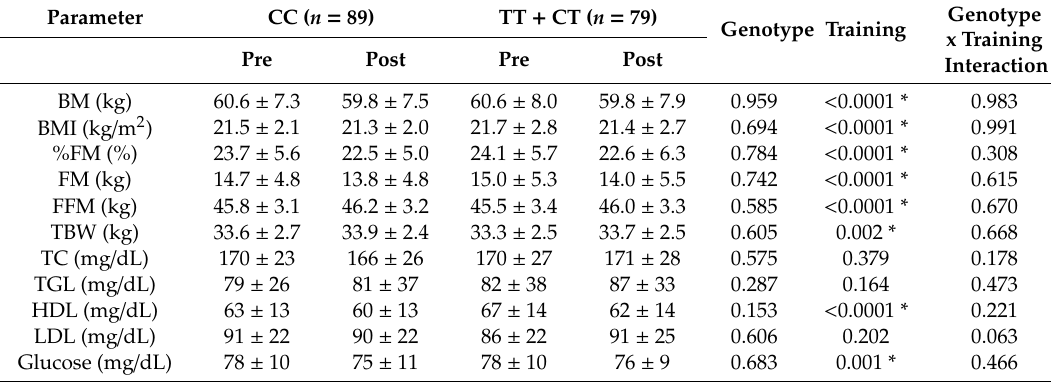
Table 2. Training Adaptation with Respect to the AMPD1 rs17602729